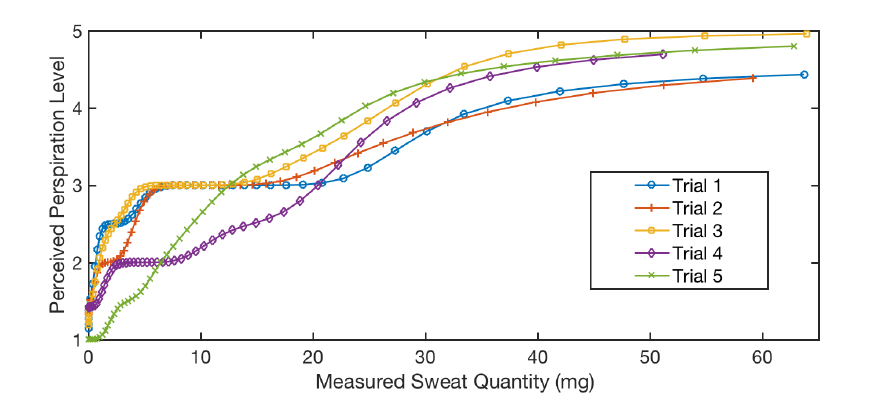
Figure 18. Perceived perspiration level base on people feeling vs. the measured